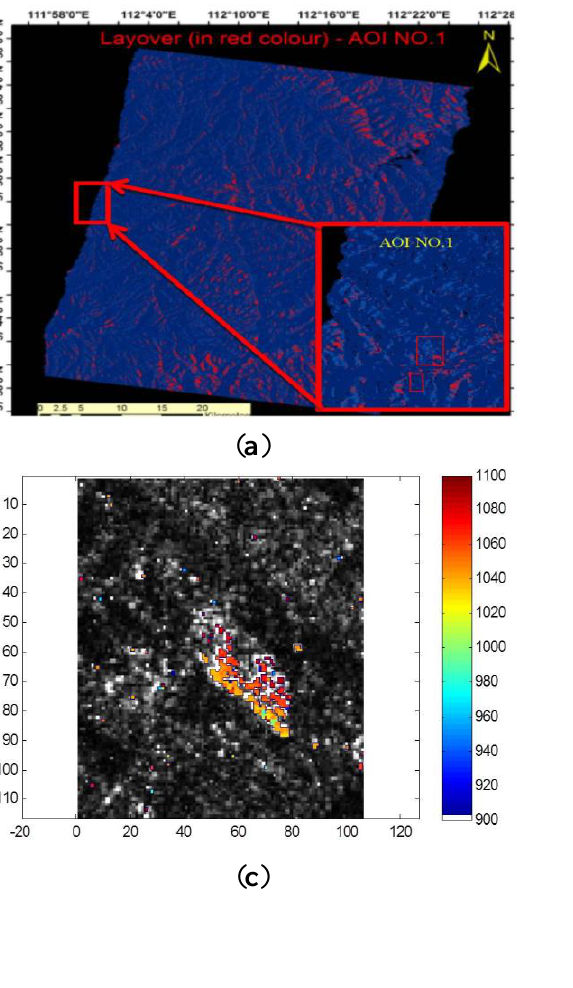
Figure 13. The 4-D TomoSAR result at AOI NO.1. ( a ) is the layover map with AOI NO.1 in the red rectangle; red on this map indicates layover. ( b ) shows two objects in AOI NO.1 by the red rectangular. ( c ) and ( e ) are the height estimation results, and ( d ) and ( f ) are the subsidence estimation results. Note that (a) was flipped and